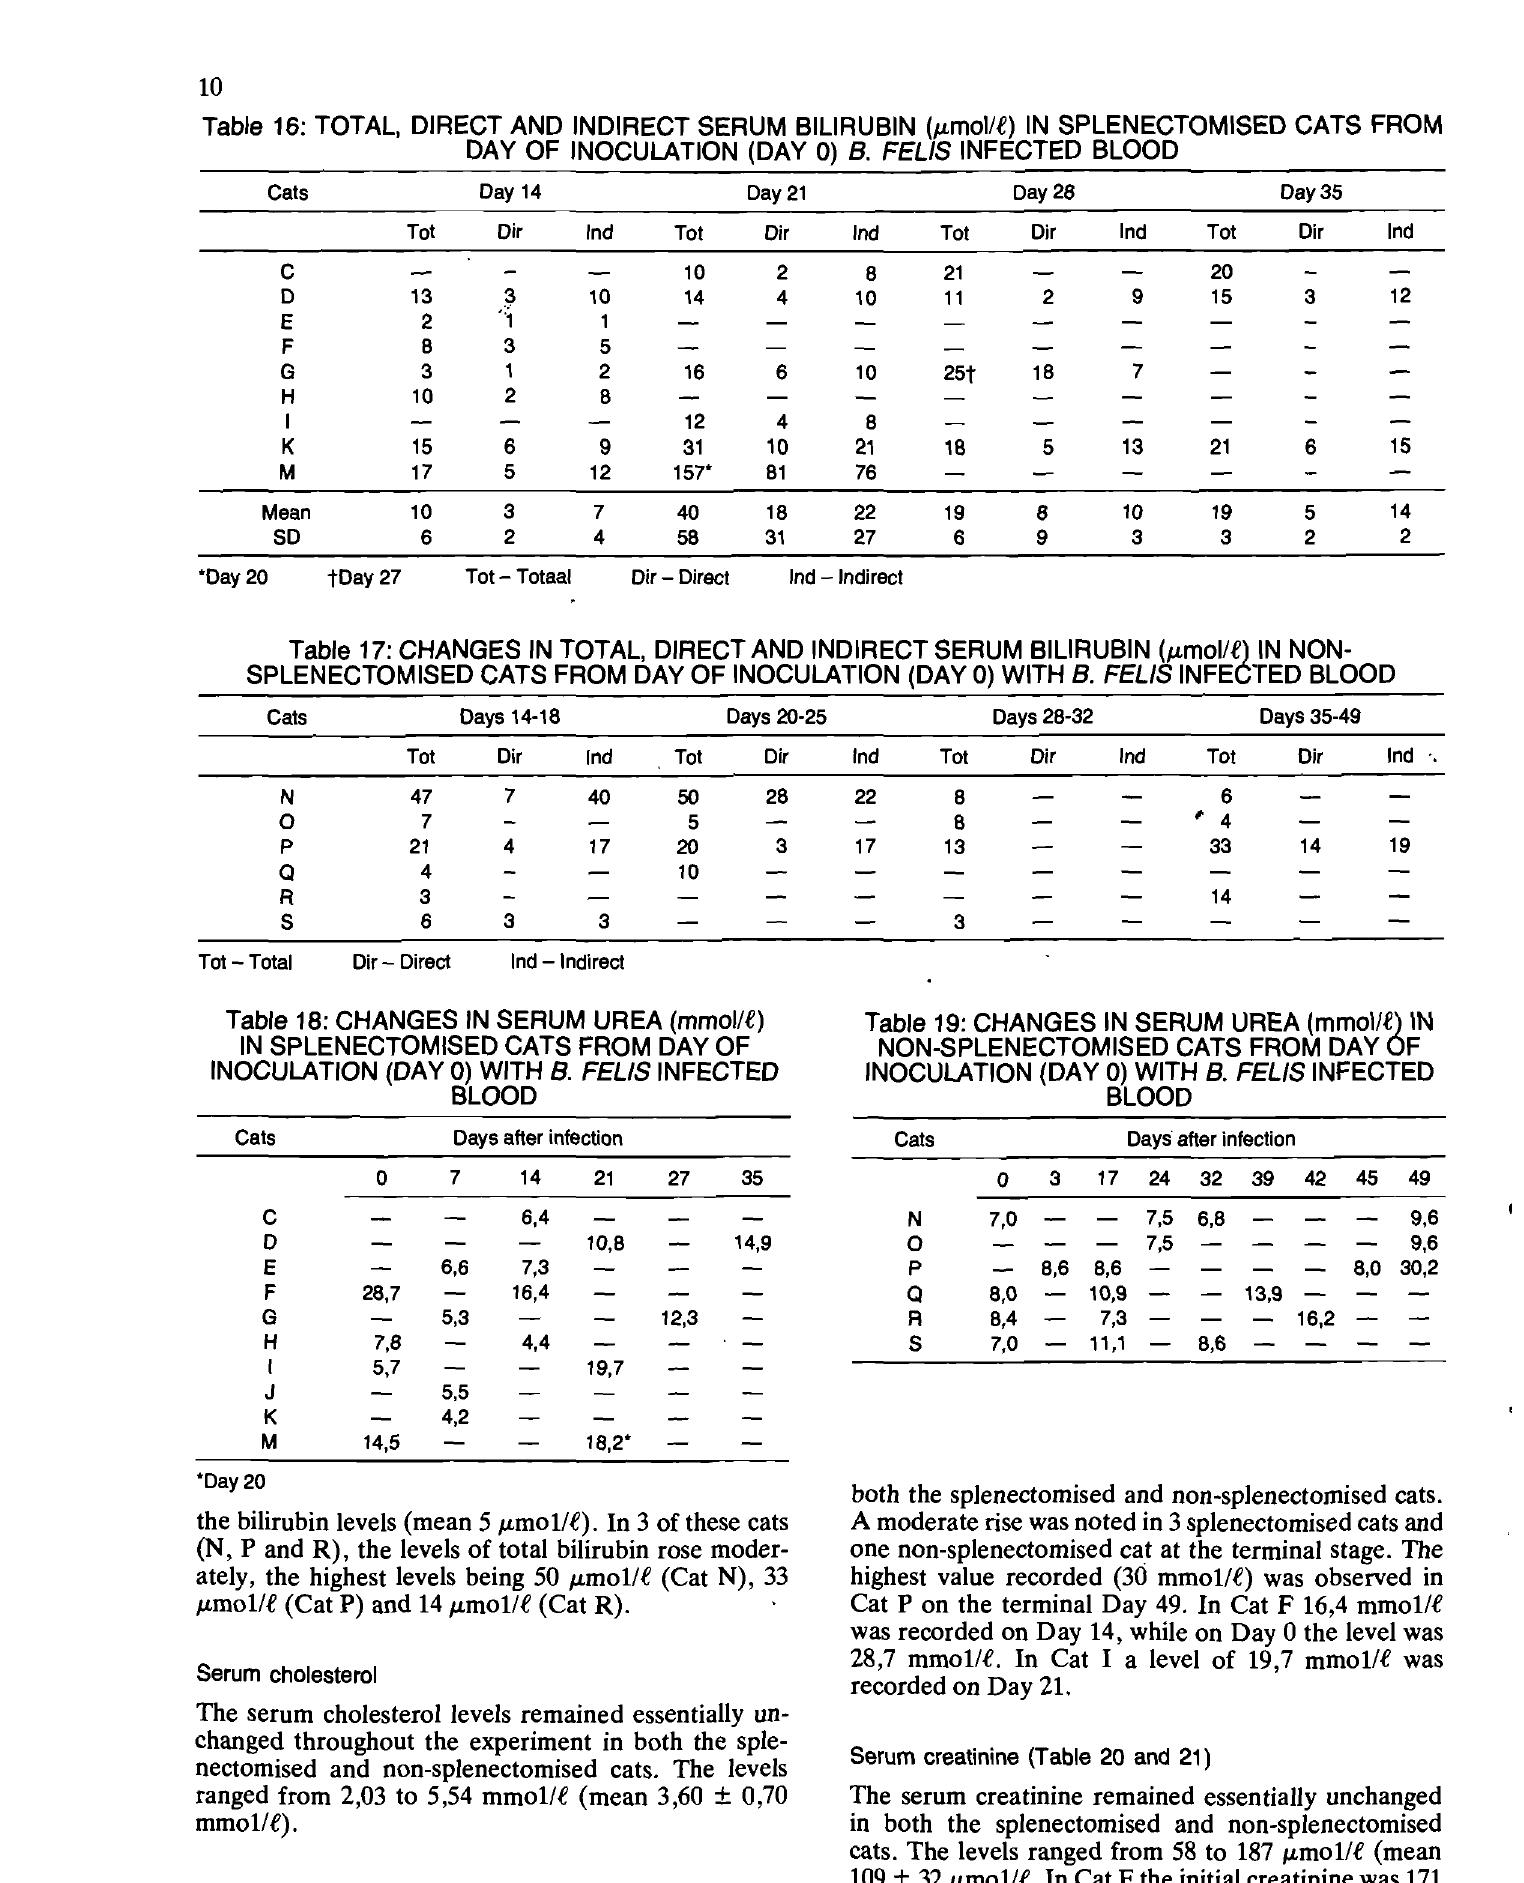
Table 16: TOTAL, DIRECT AND INDIRECT SERUM BILIRUBIN (J.Lmol/e) IN SPLENECTOMISED CATS FROM DAY OF INOCULATION (DAY 0) B. FELIS INFECTED BLOOD Cats